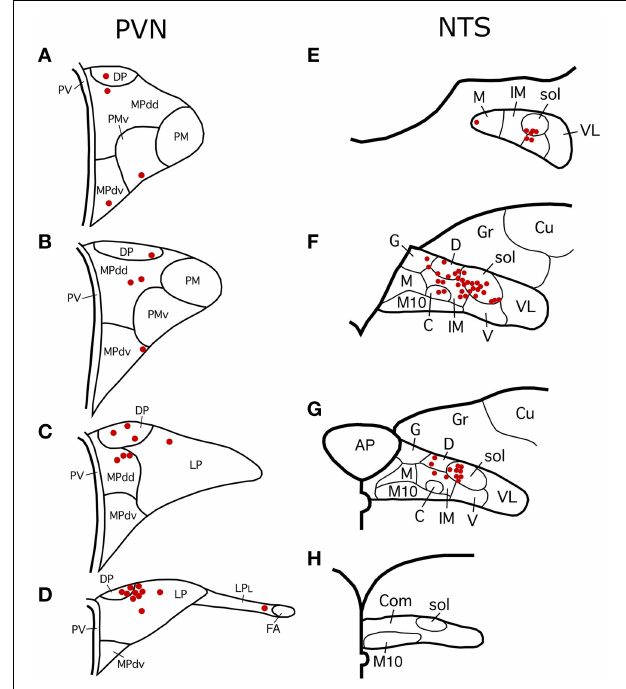
FIGURE 7 | (A–D) Schematic distribution of PRV + neurons in PVN, representing a composite of one series of sections from RF73, and one from RF87. Note that the majority of PRV + neurons are localized in the parvocellular subdivisions of PVN. Schematic subdivisions of PVN based on Hallbeck et al. (2001). Levels shown in (A–C) correspond to the levels shown in Figures 1C–E . (E–H) Schematic distribution of PRV + neurons in NTS. The mapping represents a composite of two series of sections from RF73, a long survival case following a minute PRV injection restricted to choroid. Note that the majority of PRV + neurons are localized to the dorsal, intermediate and solitary tract subdivisions of NTS. Schematic subdivisions of NTS based on Zhang and Ashwell (2001). Levels shown in (E–G) correspond to the levels shown in Figures 3C–E